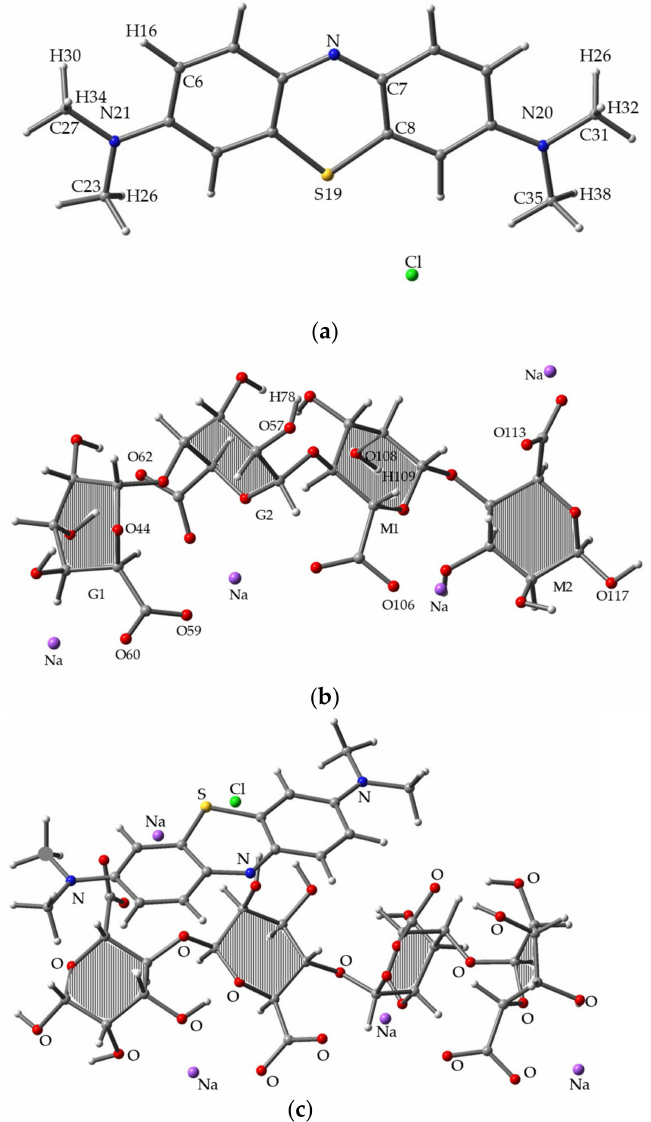
Figure 3. Optimized molecular structures for ( a ) MB, ( b ) SA, and ( c ) MB/SA at the B3LYP/6-31G(d) level of